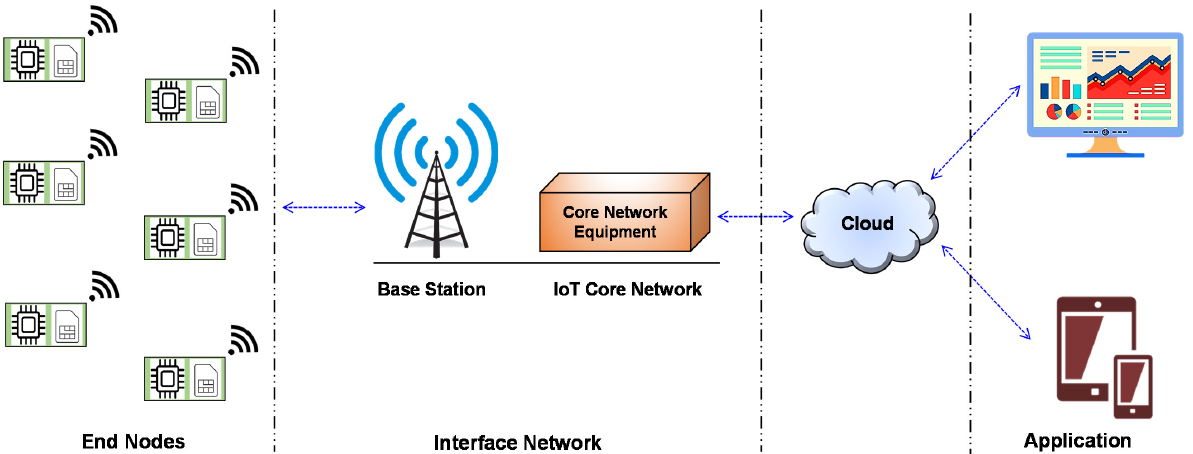
Figure 12. NB-IoT network architecture.